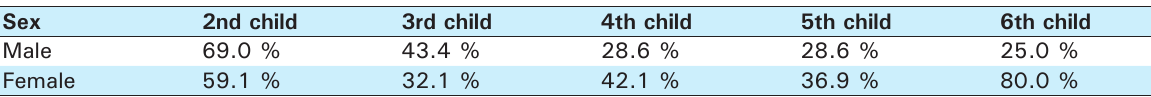
showing gender preference for males (Fig. 2)